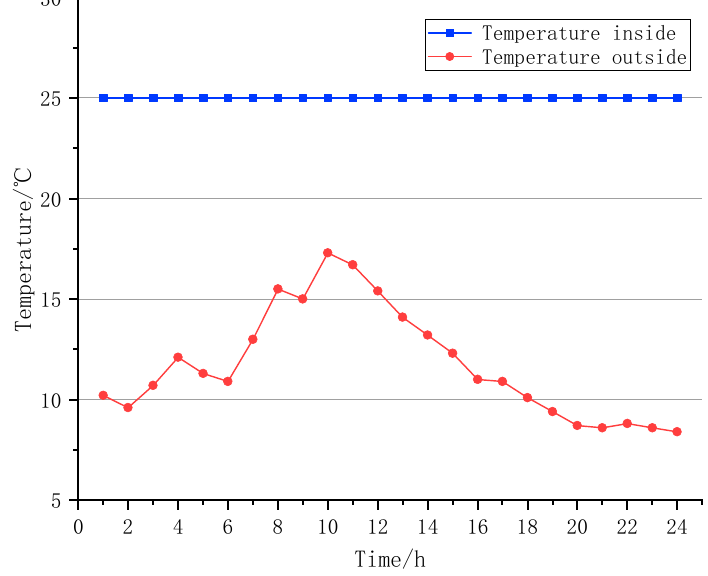
Figure 5. The temperature inside and outside of a typical greenhouse. Table 9. Time-shifting characteristics and the input time of non-time-shifting load at initial state for 13 types of electric load.